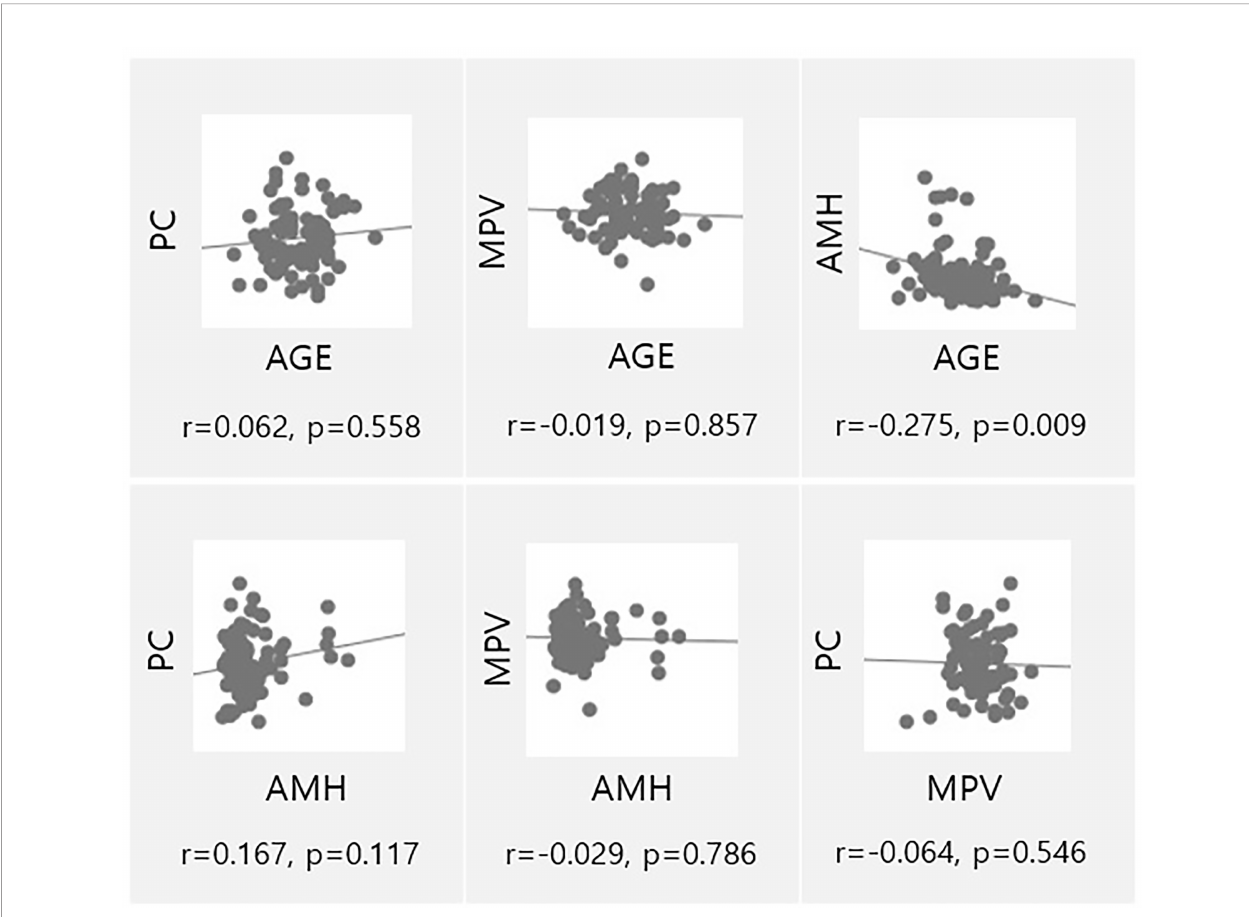
FIGURE 3 | Univariate analysis of ovarian reserve markers (AMH, Age) and parameters associated to platelets (MPV, PC). PC, Platelet count; AMH, Anti-müllerian hormone; MPV, Mean platelet volume.